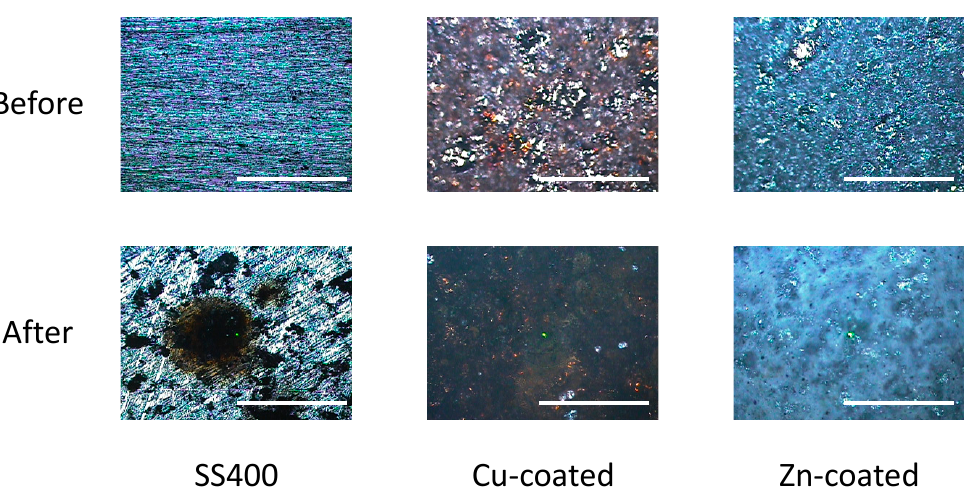
Figure 4. Optical microscopy images of the surface of the specimens before and after outdoor exposure tests. Each white bar represents 5 mm. A green center point is a laser-irradiated spot. Materials 2020 , 13 , 923